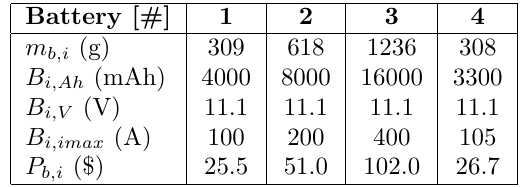
Table 6: Datasheets: Batteries. m b is the weight of the battery, while P b is the price.